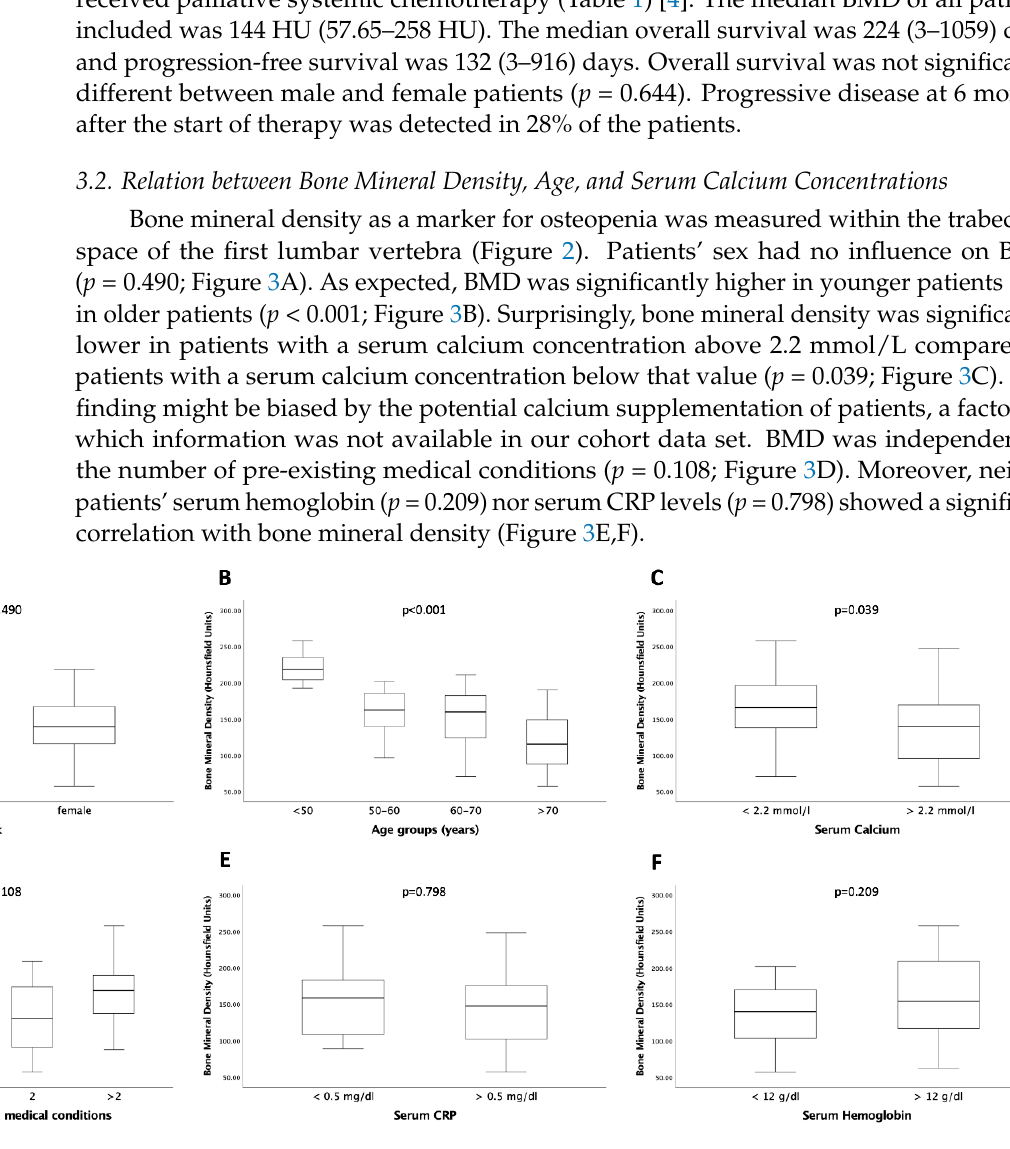
Figure 3. BMD is dependent on age and serum calcium. BMD was significantly different in different age groups ( B ) and serum calcium concentrations ( C ). For sex ( A ), pre-existing medical conditions ( D ), serum CRP ( E ), and serum hemoglobin ( F ), no significantly different BMD levels were observed. Box plots show medians, quartiles, and ranges.